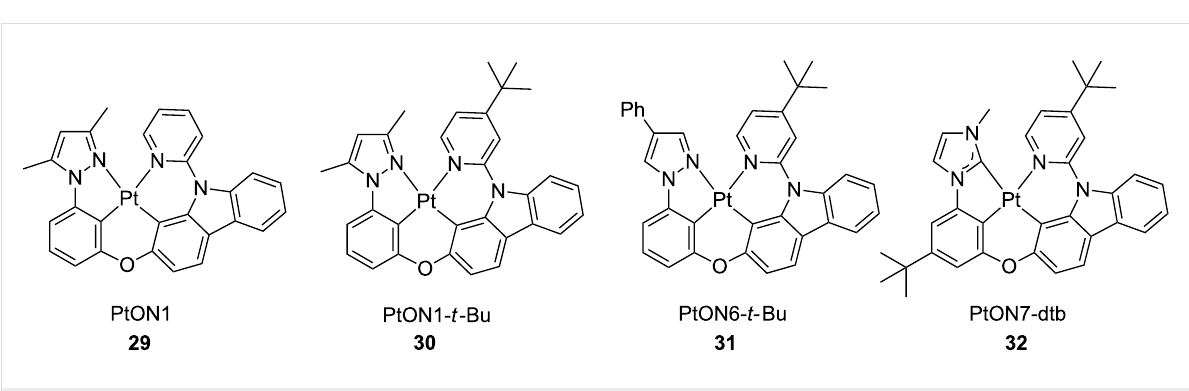
Figure 16: Molecular structure of the tetradentate platinum complexes 29 – 32 bearing N^C^C^N and C^C^C^N ligands